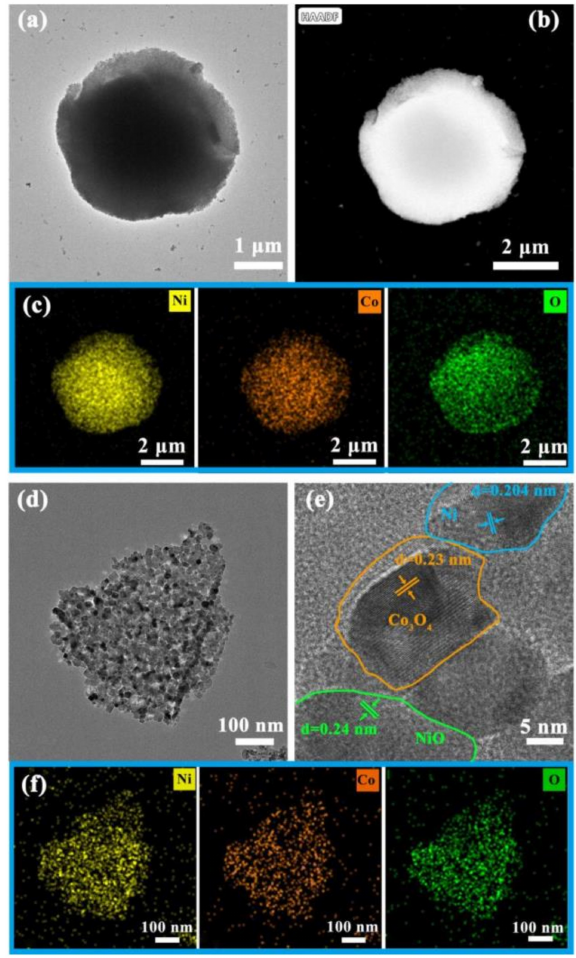
Figure 3. ( a ) TEM image of NCMO; ( b ) HAADF-STEM image of NCMO; ( c ) Corresponding el- emental mapping; ( d ) TEM image of debris of NCMO; ( e ) HRTEM images of debris of NCMO; ( f ) Corresponding elemental